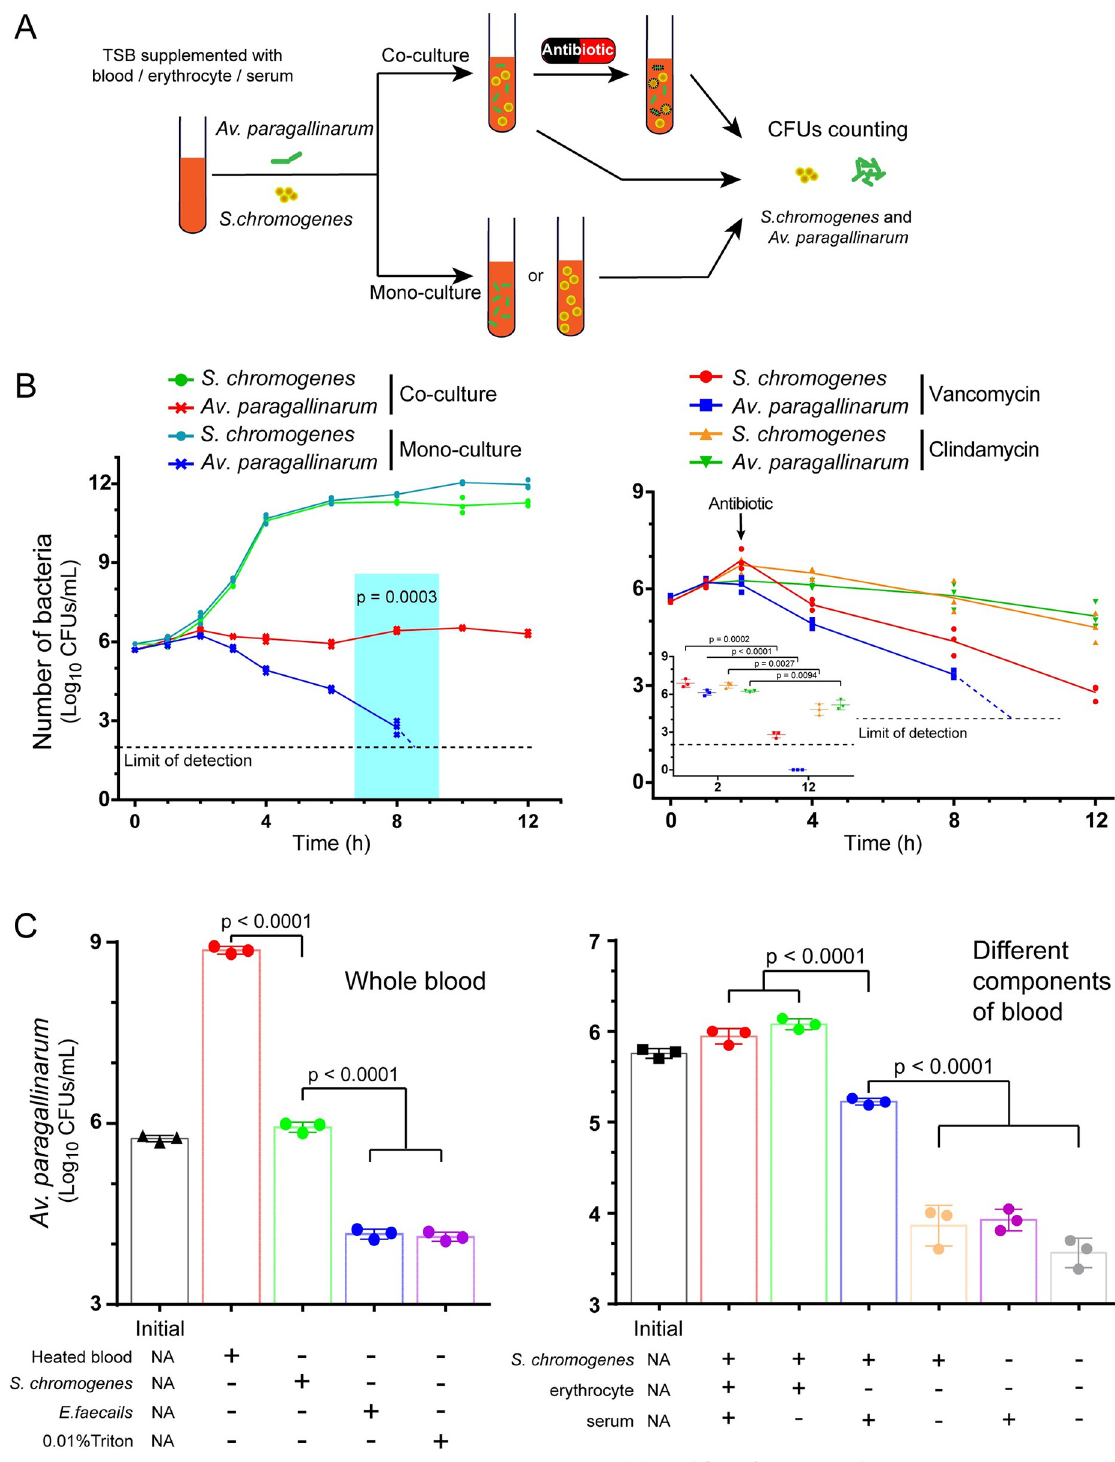
Fig 2. S . chromogenes supports the survival of Av . paragallinarum in vitro . (A) Workflow of in vitro coculture experiments. S . chromogenes SC10 and Av . paragallinarum X1-1S-1 were cocultured or monocultured in homemade broth media with or without antimicrobial agents. The CFUs/mL bacteria of all groups were subsequently calculated. (B) The growth dynamic of S . chromogenes and Av . paragallinarum in the presence of 5% (v/v) whole blood with (picture on the right) or without antimicrobial agents (picture on the left). LOD, limit of detection. P values were determined by unpaired t -test. The values of three biological replicates are shown as individual points